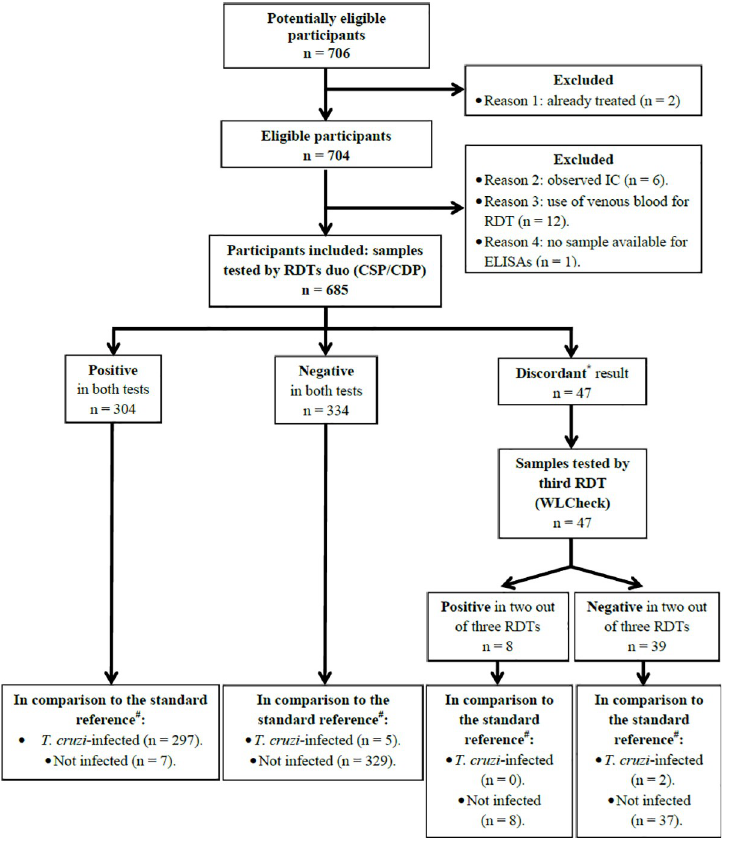
Fig 1. Study flowchart depicting the excluded subjects and the RDTs and ELISAs results of all of those included. � Amongst the 47 discordant samples between the two main RDTs: 3 were CSP positive and CDP negative, and 44 were CSP negative and CDP positive; rate of disagreement = 6.9%. Hence, following the recommended algorithm, a third RDT based on distinct antigen set was used and the agreement of two out of three techniques considered. # The standard reference is the algorithm based on the agreement of two ELISAs, as recommended by the WHO/PAHO [4,